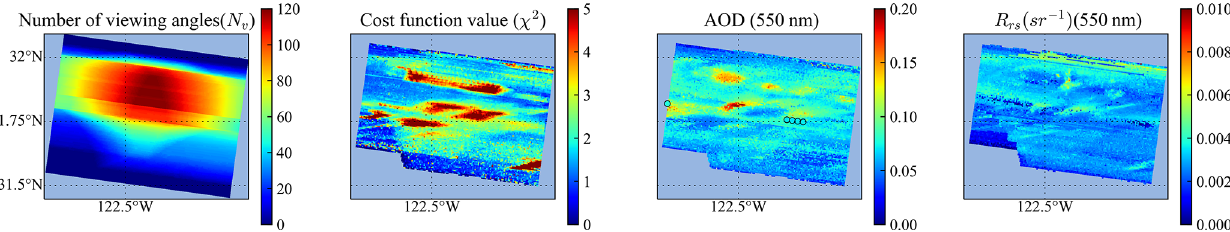
Figure 16. Same as Fig. 15 but for Scene 2. For R rs , viewing angles at least 40 ◦ away from the solar specular reflection direction are used to avoid sunglint as shown in Fig.